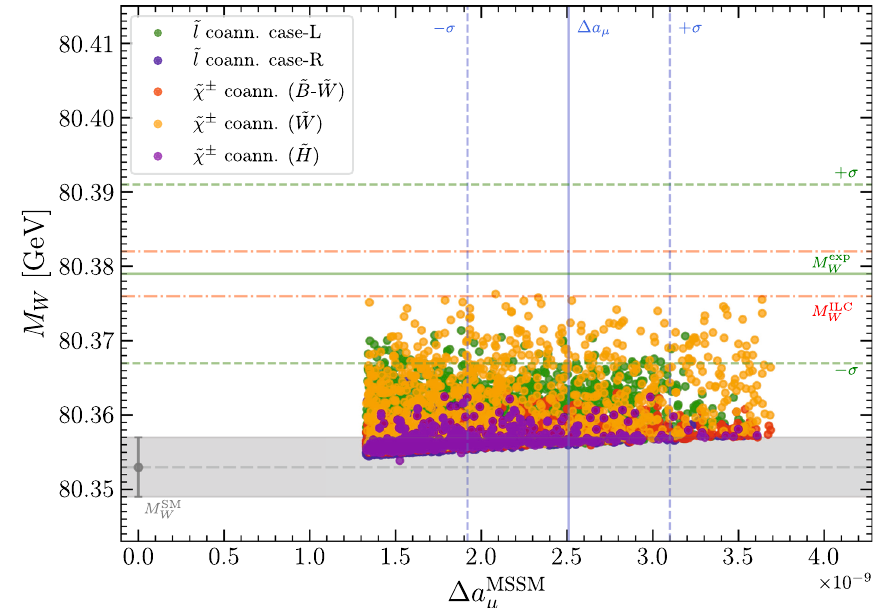
Fig. 1 Results for the five considered scenarios in the (cid:2) a MSSM μ – M W Eq. (3) (solid) and its ± 1 σ range (dashed). The displayed points are restricted to the ± 2 σ range of (cid:2) a μ . The horizontal lines indicate the plane, where the prediction for (cid:2) a MSSM μ has been evaluated with the current central value for M exp (solid green), the current ± 1 σ uncer- W code GM2Calc-1.7.5 [138]. The points for the ˜ l ± -coannihilation tainties (green dashed) and the anticipated ILC ± 1 σ (red dot-dashed) case-L and case-R, the ˜ χ ± -coannihilation case, the wino and the hig- 1 uncertainties. The SM prediction is shown as a point for (cid:2) a MSSM μ = 0, gsino case are shown in green, blue, red, orange and violet, respectively. while the gray band indicates the theoretical uncertainty of the SM The vertical blue lines indicate the central value of (cid:2) a μ as given in prediction for M W from unknown higher-order corrections